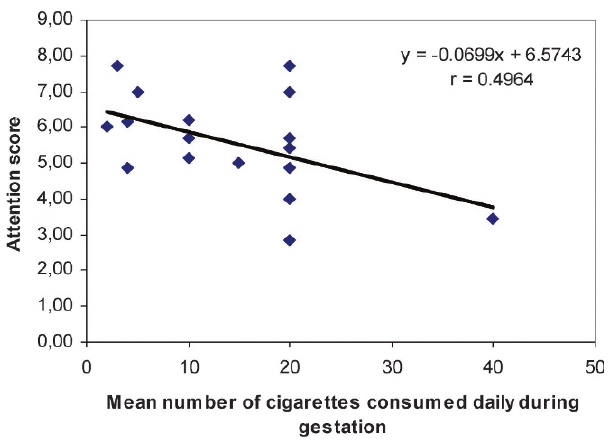
Figure 1 - Correlation between the number of cigarettes consumed during gestation (X) and neonatal attention score (Y).